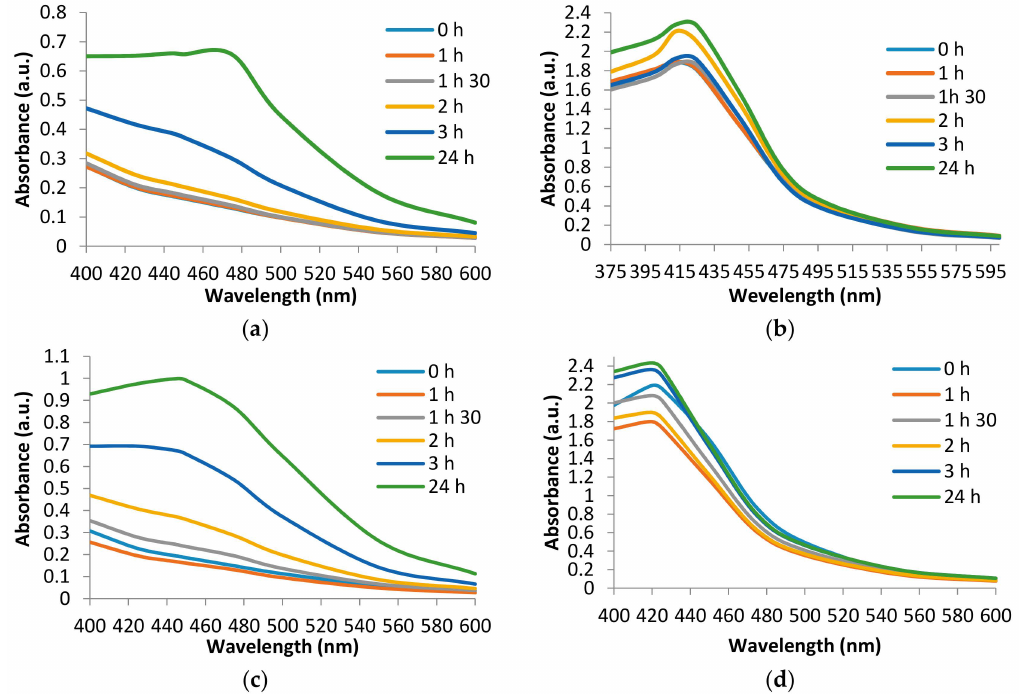
Figure 2. UV–visible absorption spectra of synthesized silver nanoparticles using tested solutions: ( a )TS1—beechbarkextract, pH = 4, AgNO 3 ; ( b )TS2—beechbarkextract, pH = 9, AgNO 3 ; ( c )TS3—beech bark extract, pH = 4, AgC 2 H 3 O 2 ; ( d ) TS4—beech bark extract, pH = 9, AgC 2 H 3 O 2